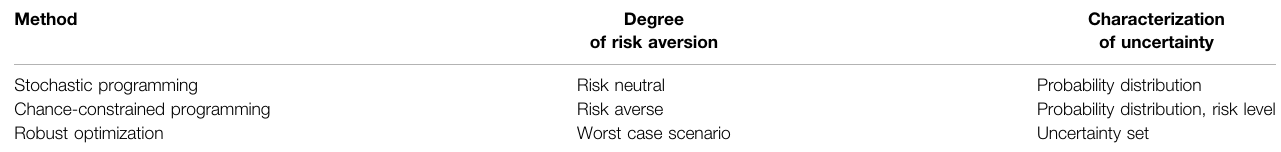
TABLE 2 | Summary of stochastic programming, chance-constrained programming, and robust optimization.